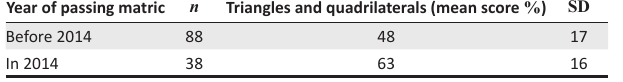
TABLE 9: Performance of students in the triangles and quadrilaterals concepts in relation to pre-2014 matriculants and matriculants of 2014. Year of passing matric n Triangles and quadrilaterals (mean score % ) SD Before 2014 88 48 17